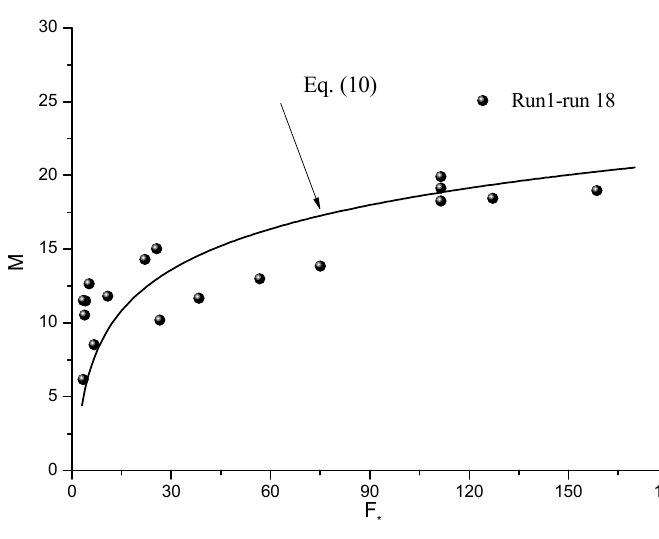
Figure 12. The relationship between F * and M .